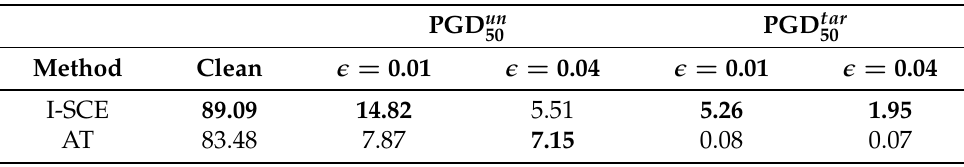
Table 2. Adversarial training with PGD attack on CIFAR10.